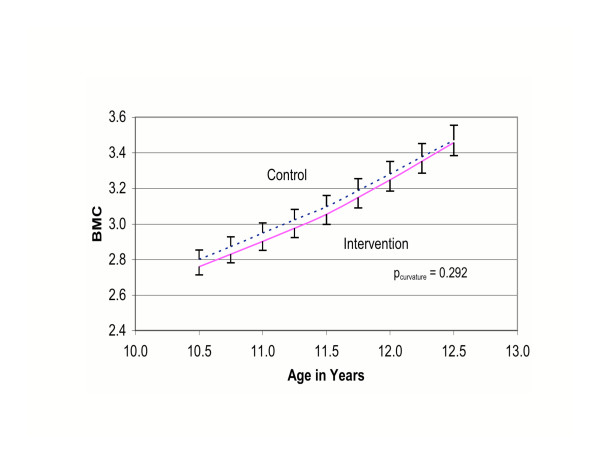
Femoral Neck of R. Hip: BMC (2xSE bars). CALGIRLS Study